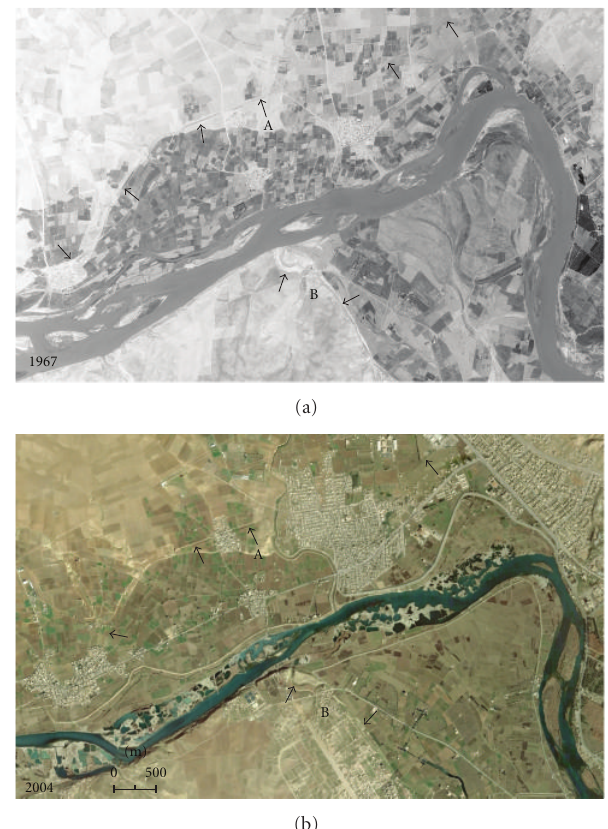
Figure 18: The remains of the Tarbisu canal (A) in the area of Rashidiya, north-west of Nineveh, visible in a Gambit KH-7 photo of June 9, 1967, and in a pan-sharpened (bands 3-2-1) QuickBird-2 image of 2004; a canal dated to the 20th century is visible south of the river